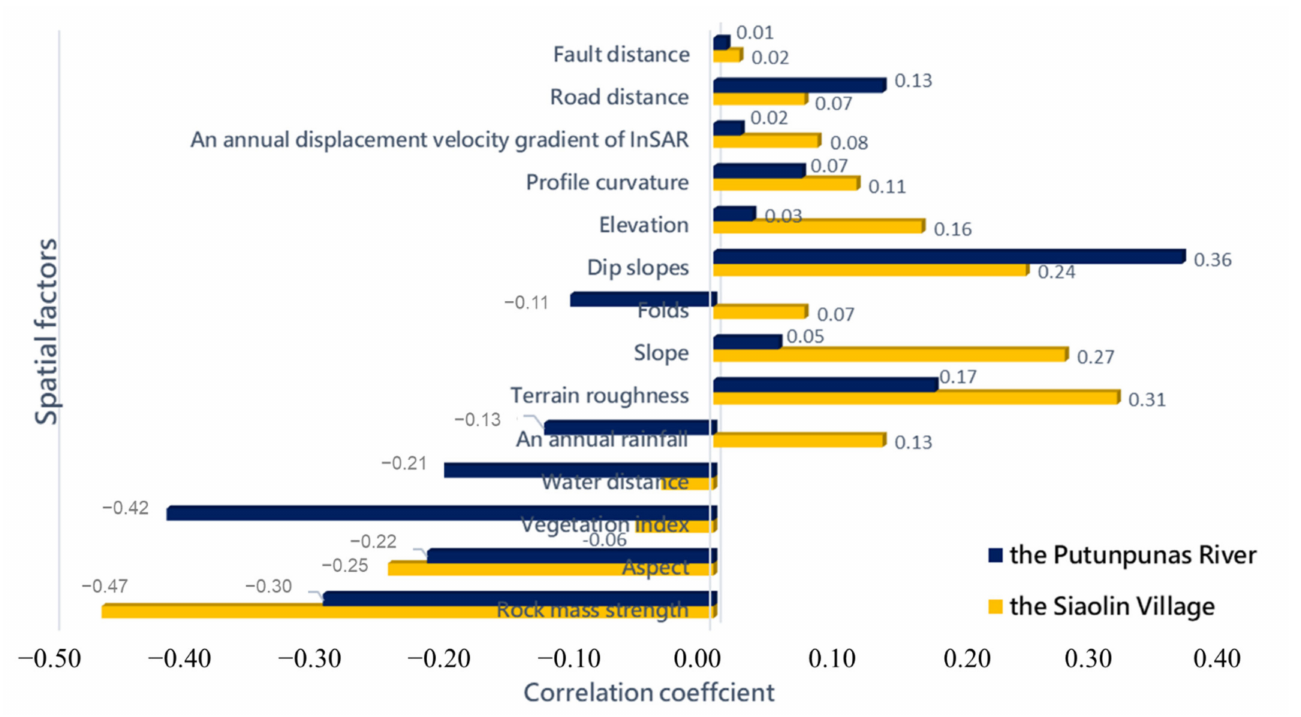
Figure 5. Histogram of correlation coefficient between landslides and the 14 spatial factors in the slope units. Table 1. Correlation coefficients and p -values, quantified according to the relationship between landslides and the 14 spatial factors in the slope